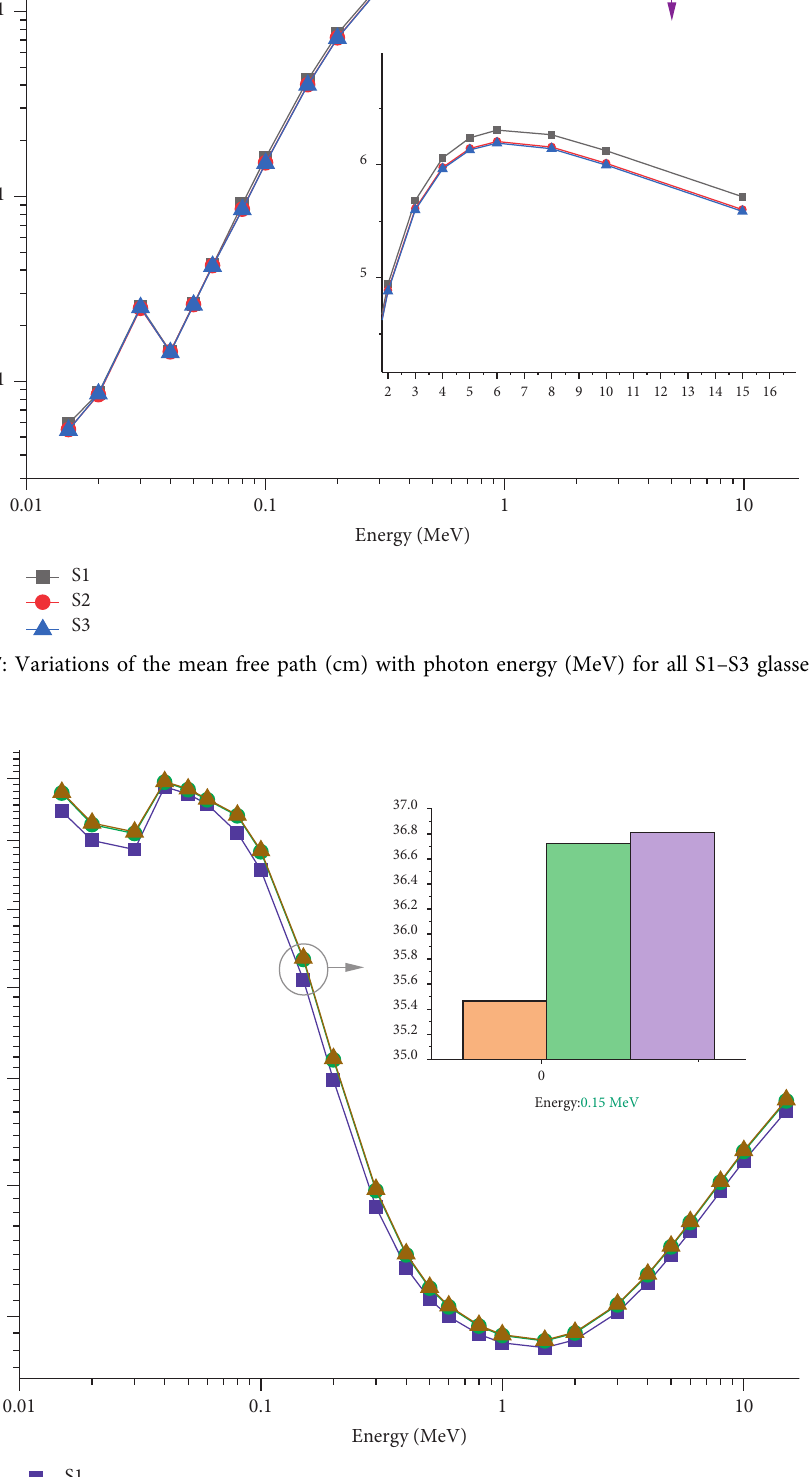
eff ) with photon energy (MeV) for all S1–S3